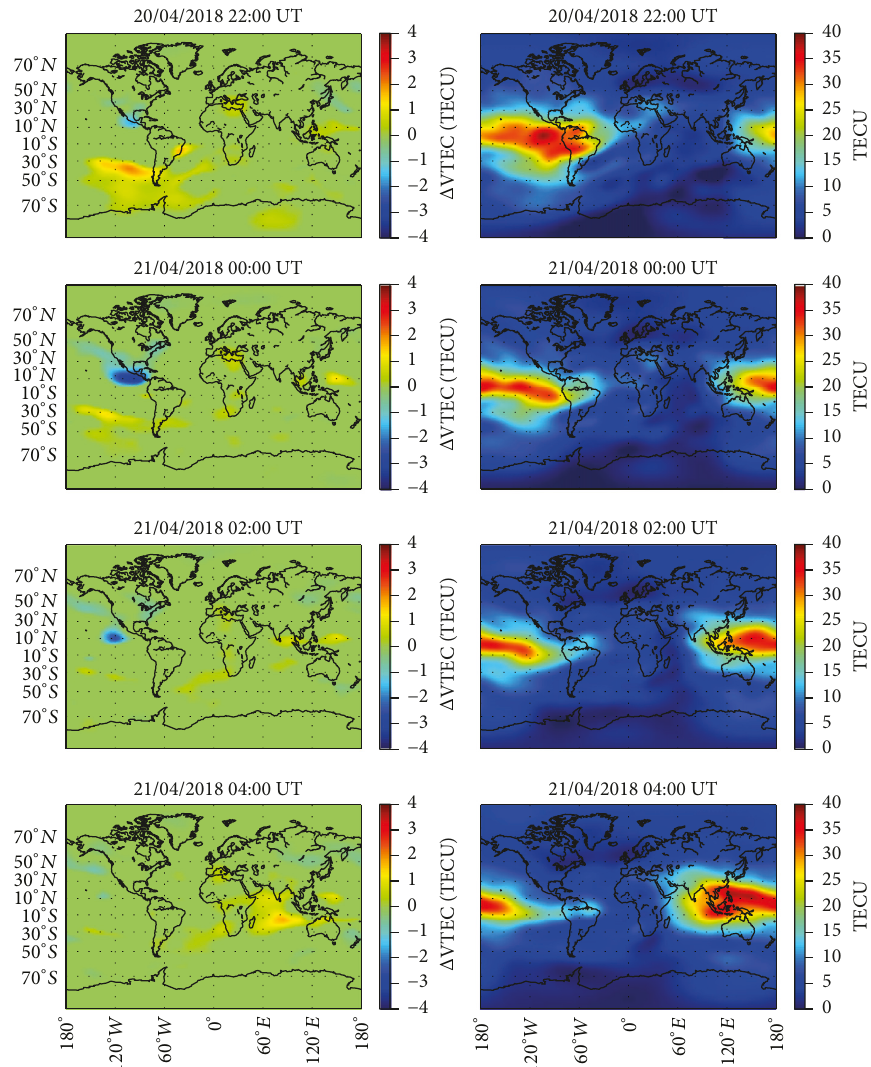
Figure 5: Left column: differential VTEC maps between April 20, 2018 (22:00 UT) and April 21, 2018 (04:00 UT). Right column: GIMs between April 20, 2018 (22:00 UT), and April 21, 2018 (04:00